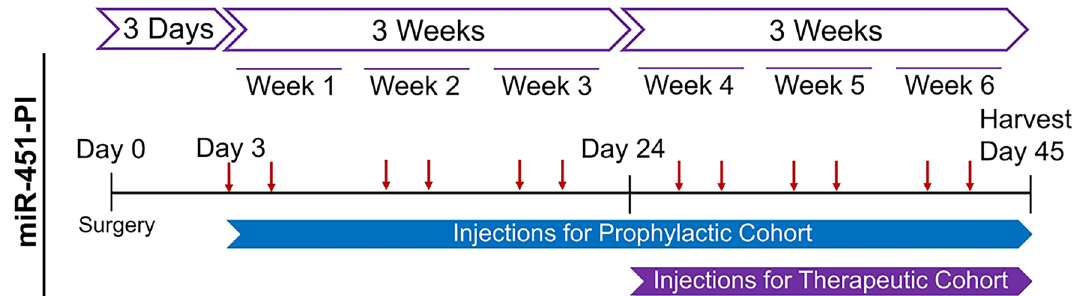
Figure 1. In-vivo experimental methods for miR-451-PI study. Eighteen Sprague Dawley rats underwent a bilateral ACLT surgery to induce OA. Two animals were used as controls (n = 4). The eighteen animals were split into two cohorts: 1) a prophylactic cohort that received intra-articular injections of miR-451-PI (n = 9) in left hind limbs or NC-PI (n = 9) in right hind limbs twice-weekly (red arrows) three days following surgery for a total duration of 6 weeks, and 2) a therapeutic cohort where we allowed OA to develop for 3 weeks before beginning the same injection regimen (n = 9 per treatment group, but one animal died resulting in an n = 8) for 3 weeks until animals were euthanized on day